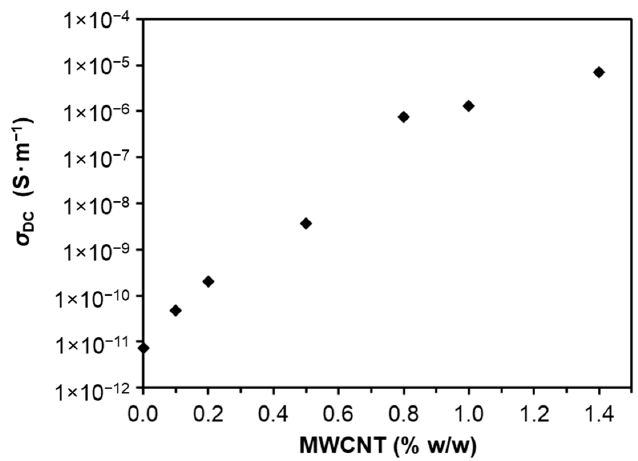
Figure 4. DC electrical conductivity, σ DC , at room temperature as a function of MWCNT concentra- tion (0%, 0.1%, 0.2%, 0.5%, 0.8%, 1%, 1.2%, and 1.4% w / w ) in LS-based PU.